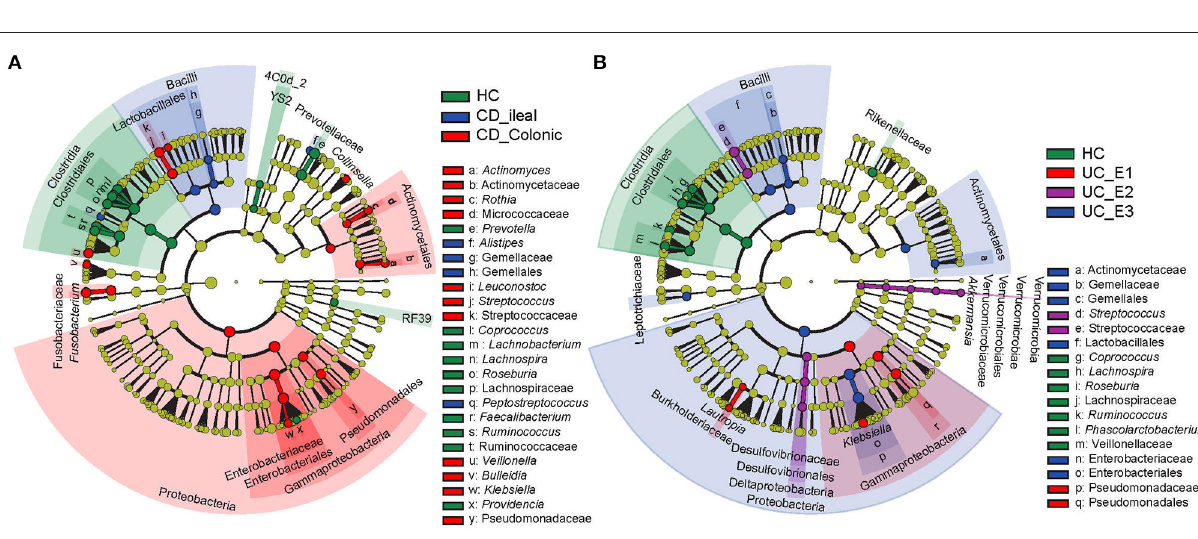
FIGURE 4 | Gut microbial biomarkers for disease location identified using LEfSe. Location classification was determined for CD (A) and UC (B) . CD was classified as ileal or colonic, and UC was classified as extensive UC (pancolitis, E3), left-sided (distal) UC (E2), or ulcerative proctitis (E1). HC, healthy